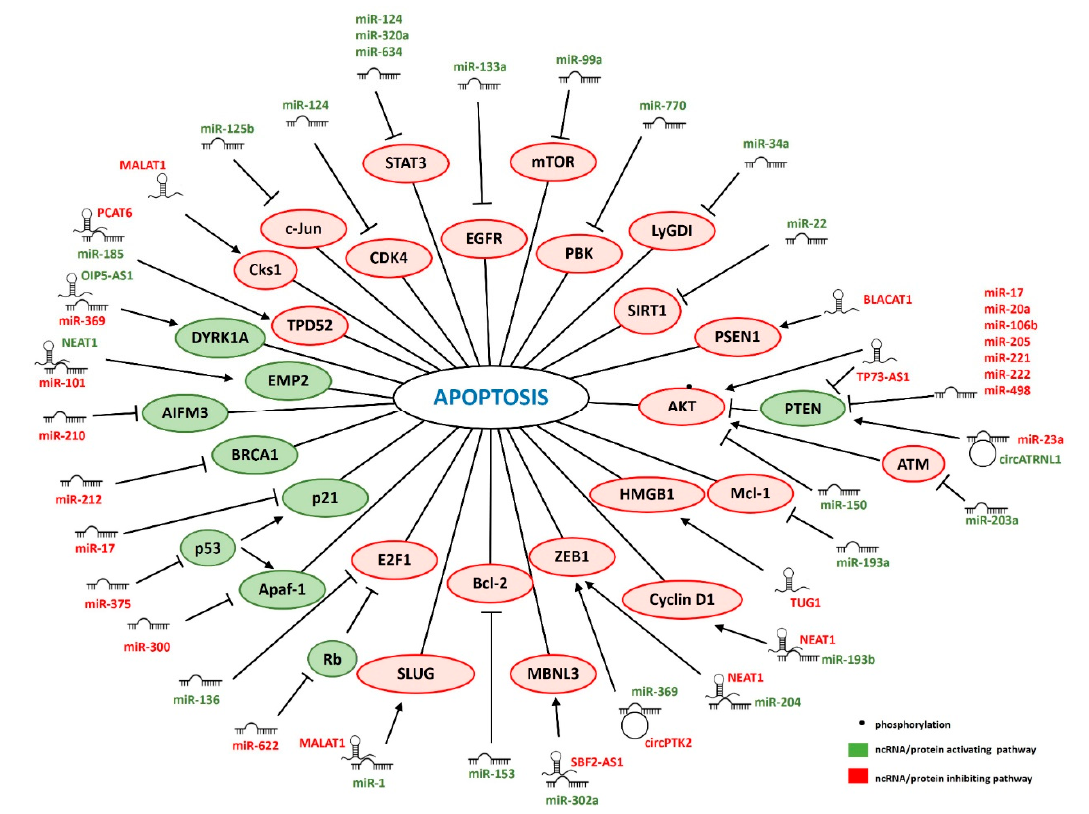
Figure 2. ncRNAs regulating IR-induced apoptosis. ncRNAs promoting (green) or inhibiting apoptosis (red). Pro-apoptotic genes are indicated in green and anti-apoptotic in red.